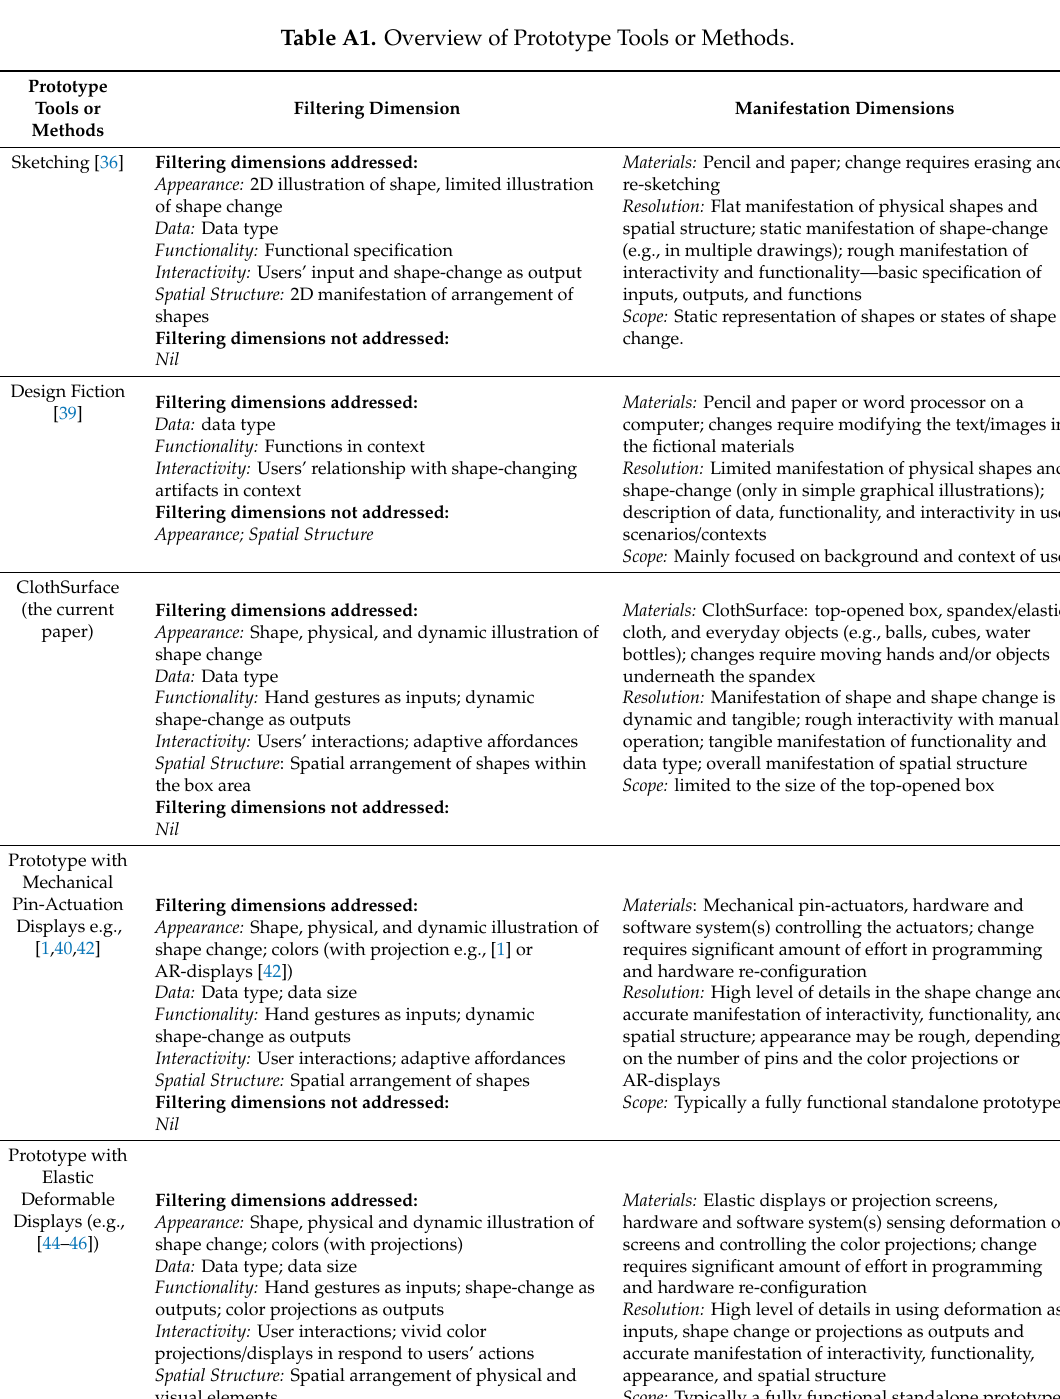
Table A1. Overview of Prototype Tools or